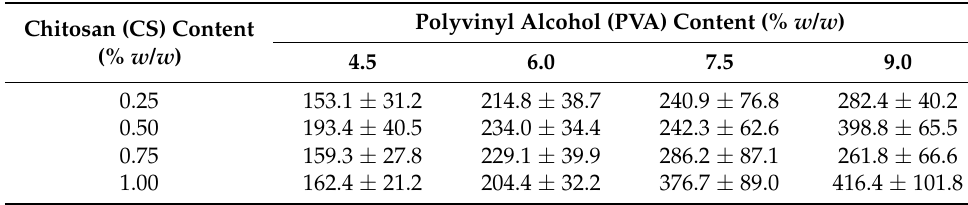
Table 4. Average fiber diameter (nm) for the electrospun fibers obtained from different solutions of PVA and CS (PVA|CS).